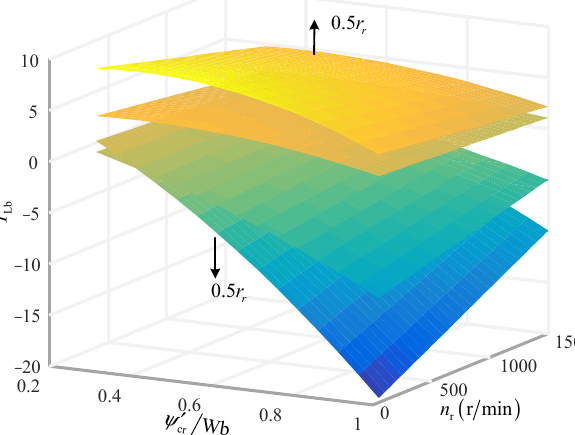
Figure 7. The bounds of the load torque when the PM stator resistance is negligible.